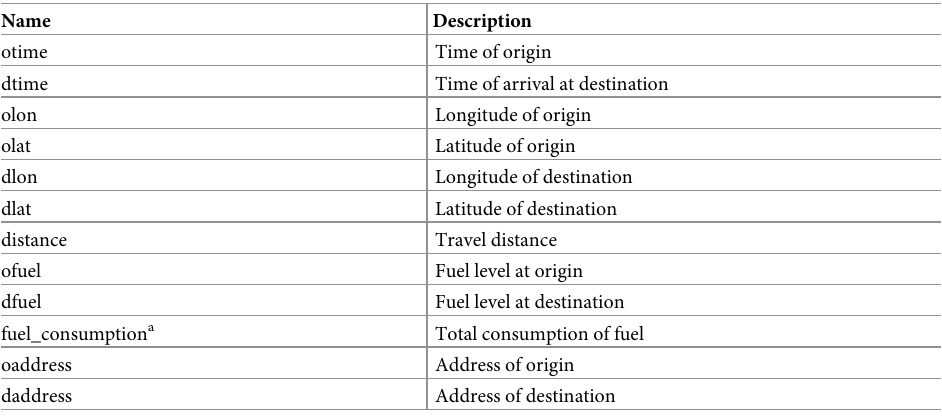
Table 1. Description of booking data